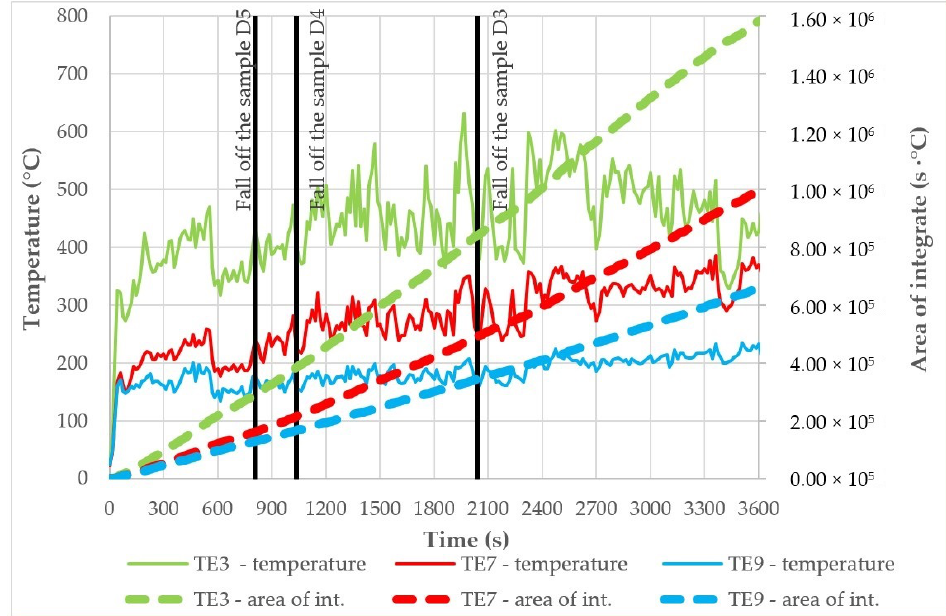
Figure 13. Temperature measurement results for TE3, TE7, and TE9 thermocouples, and the increas- ing integral for the temperature–time function, along with the determination of the falling-off time of individual